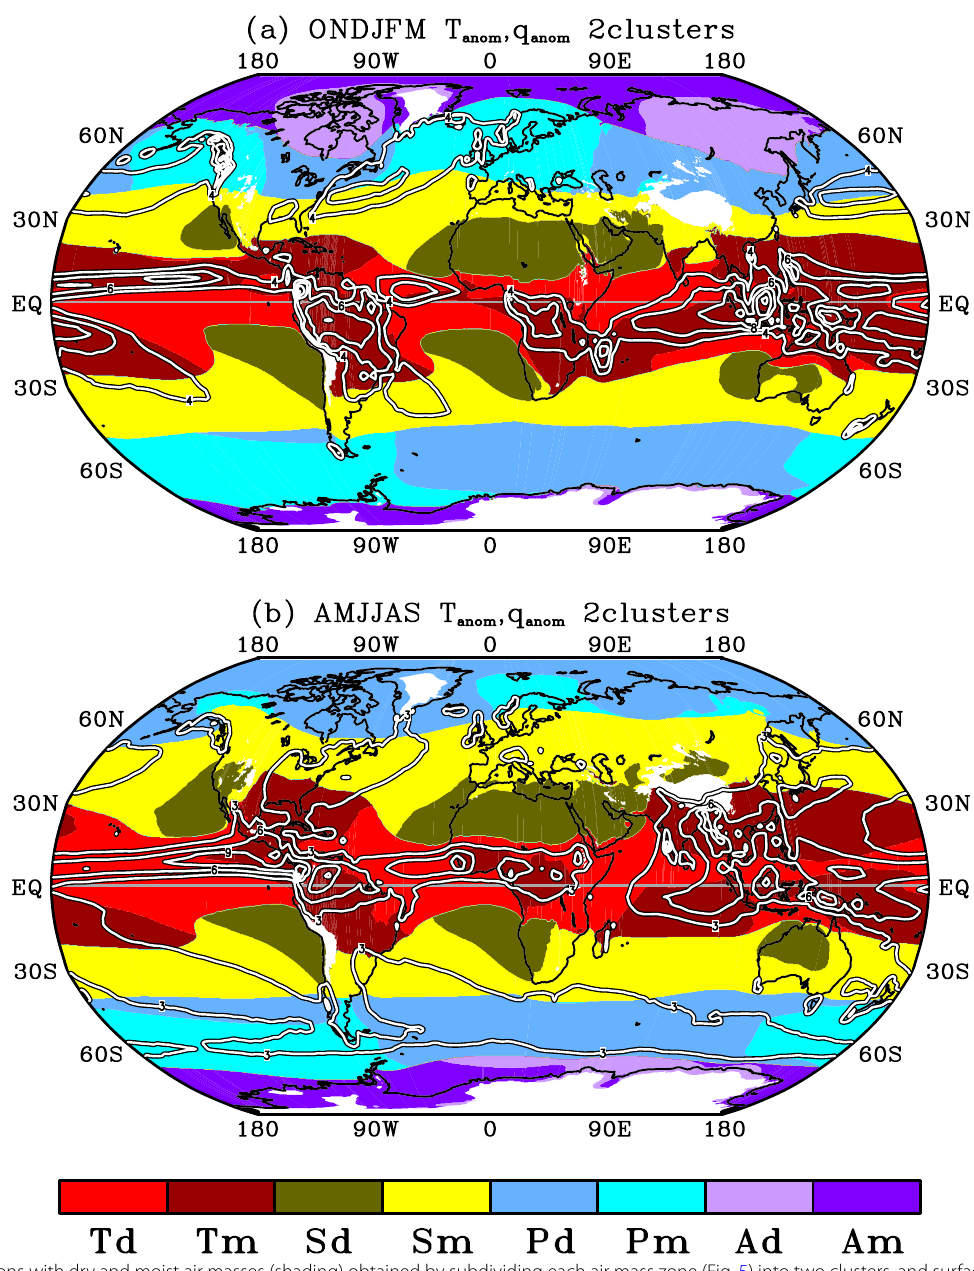
Fig. 9 Regions with dry and moist air masses (shading) obtained by subdividing each air mass zone (Fig. 5) into two clusters, and surface precipitation greater than 3 mm day − 1 (white contour) in the ( a ) O–M half‑year and ( b ) A–S half‑year. The contour interval is 3 mm day − 1 . The blank areas mean the same as in Fig. 5. Td: Tropical dry, Tm: Tropical moist, Sd: Subtropical dry, Sm: Subtropical moist, Pd: Polar dry, Pm: Polar moist, Ad: Arctic/Antarctic dry, Am: Arctic/Antarctic